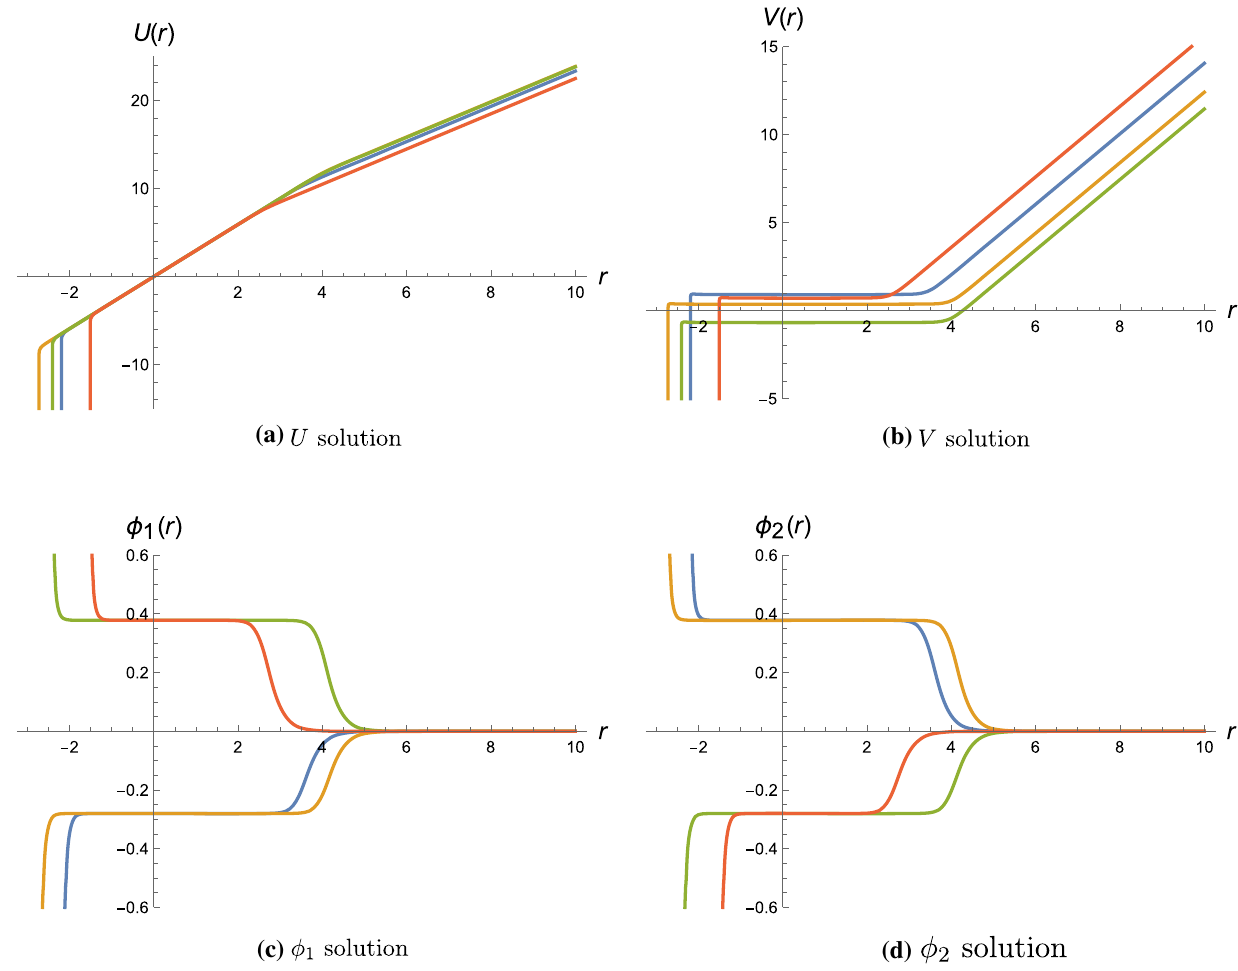
Fig. 2 RG flows from the N = 4 AdS 7 critical point as r → ∞ to AdS 5 × R 2 fixed points and curved domain walls for SO ( 2 ) × SO ( 2 ) twist in SO ( 5 ) gauge group. The blue, orange, green and red curves refer to p 2 = − 6 , − 2 , 1